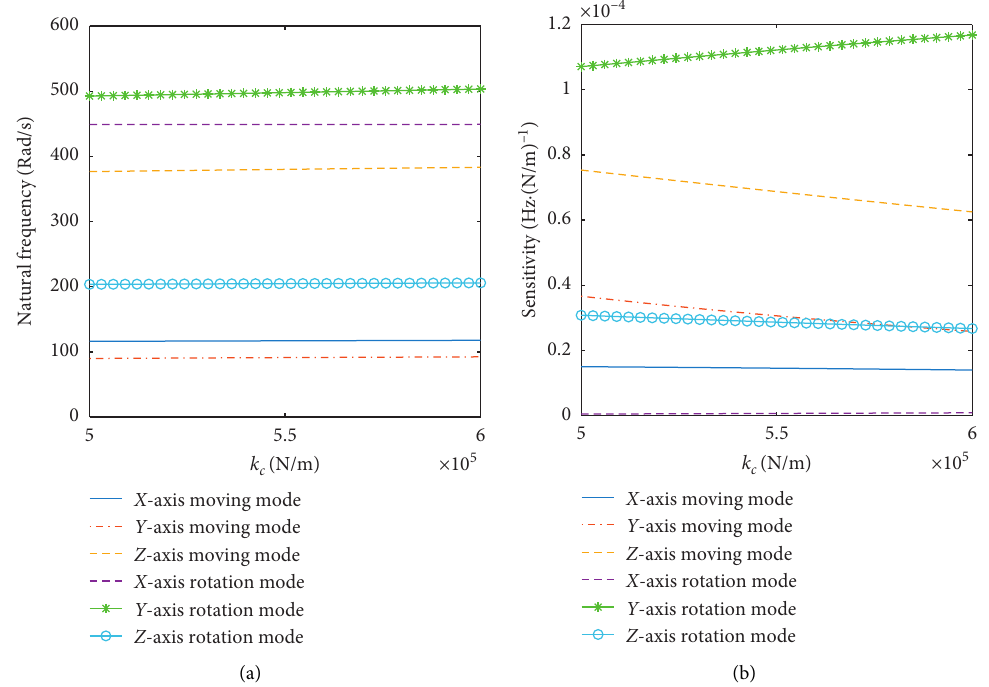
Figure 11: Curve of variation of natural frequency and its sensitivity with stiffness of outer leg 3. (a) Natural frequency. (b) Sensitivity of natural frequency to the stiffness of outer leg 3.